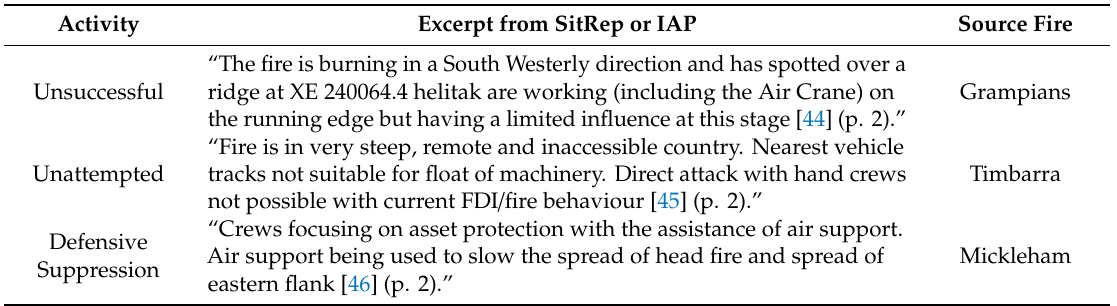
Table 3. Illustrative excerpts of unsuccessful, unattempted, and defensive suppression. Activity Excerpt from SitRep or IAP Source Fire Unsuccessful